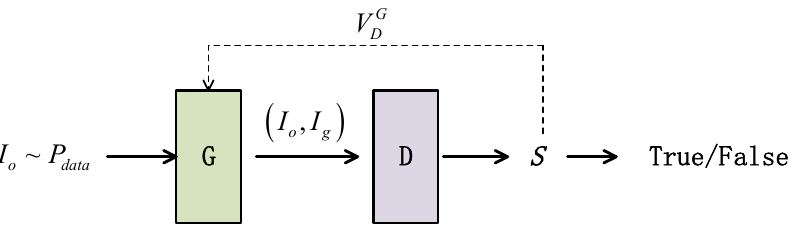
Figure 2. The framework of